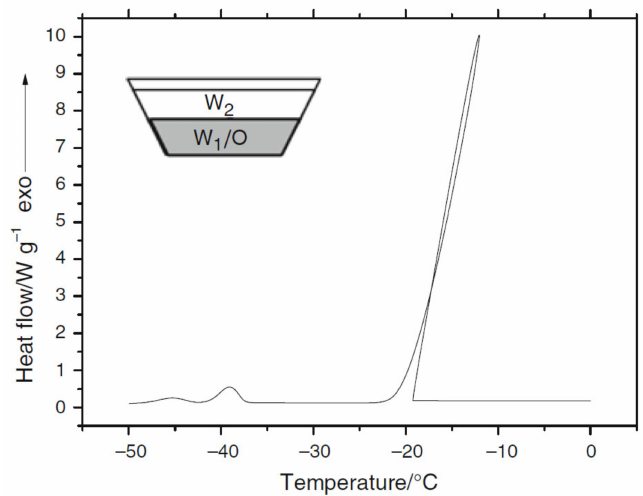
Figure 8. Exampleofadifferentialscanningcalorimetry(DSC)plotfordoubleemulsions.